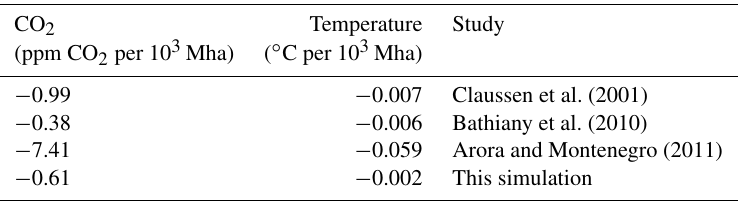
Table A3. CO 2 and temperature sensitivities to forest regrowth (including land-use change) in Earth system models. Area-weighted CO 2 and temperature for the last 20 simulation years (this simulation and Arora and Montenegro, 2011), the last 30 simulation years (Bathiany et al., 2010), and an average of the last 150 simulation years (Claussen et al.,